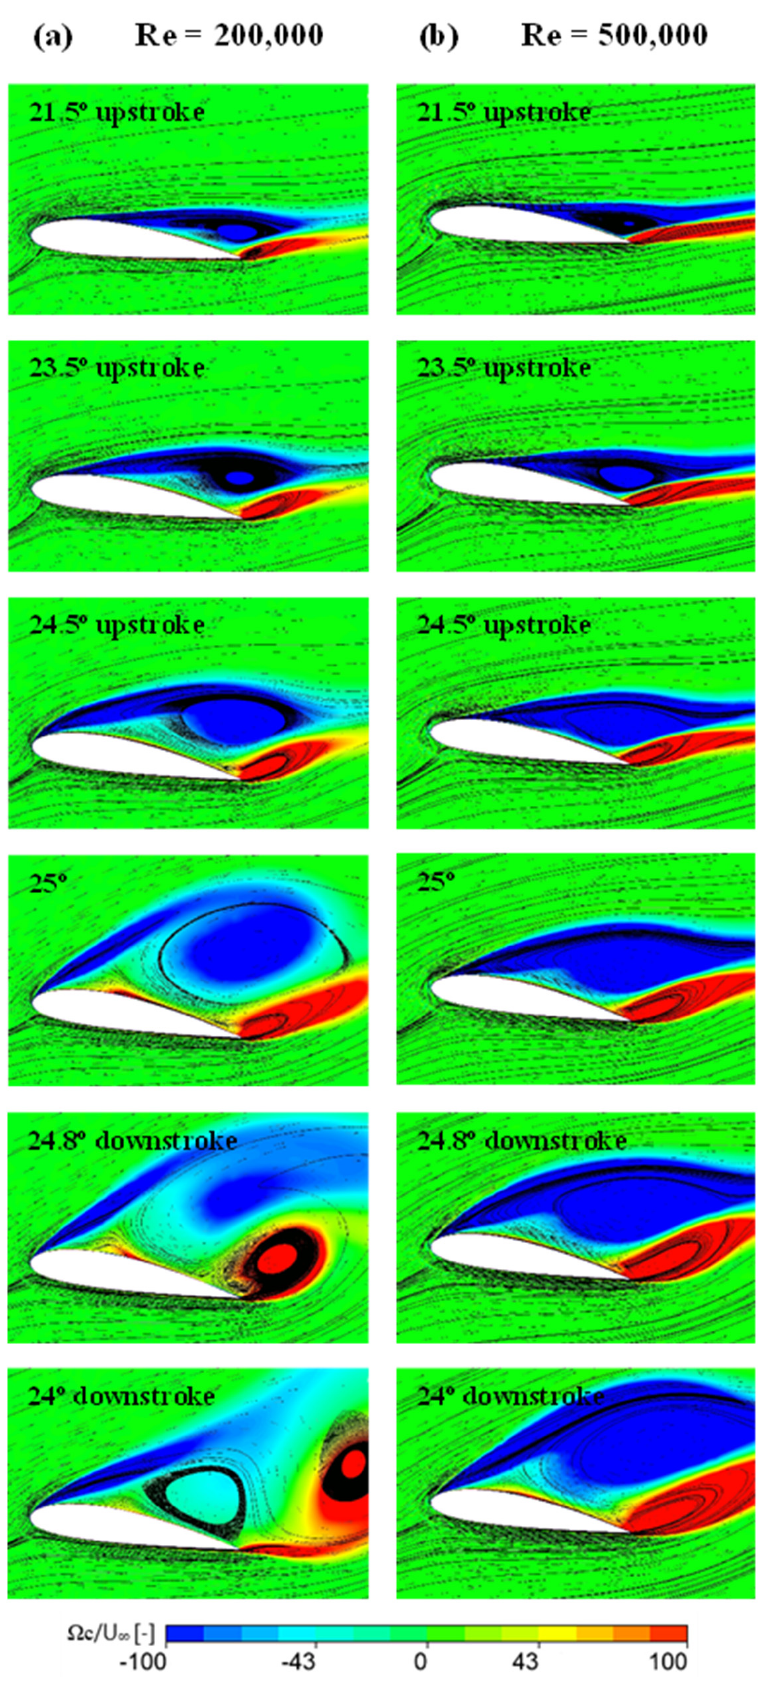
Figure 7. Vorticity contours at different α angles for ( a ) Re = 2 × 10 5 and ( b ) Re = 5 × 10 5.